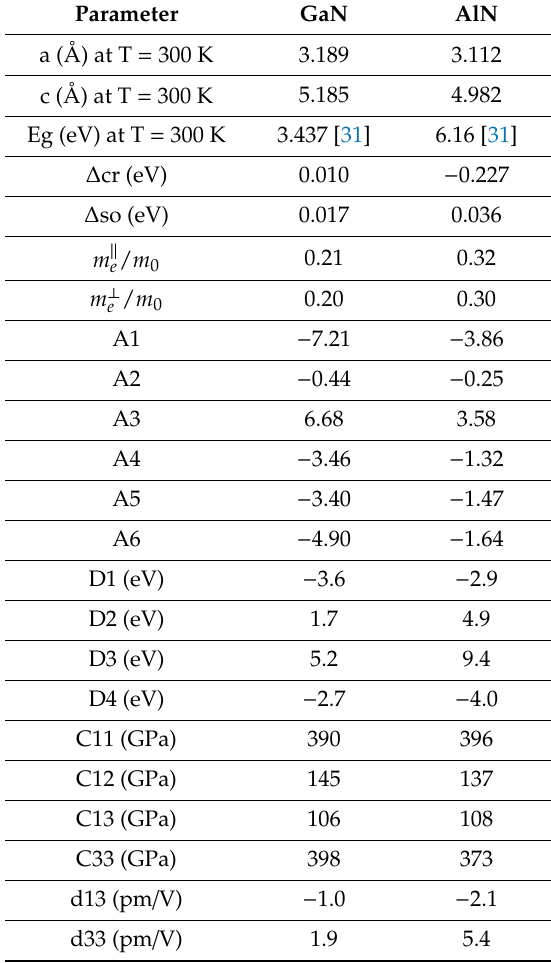
Figure 1. ( a ) Schematic of the AlGaN-delta-GaN structure studied in this work. The barrier thickness is fixed at 6 nm and the sub-QW thickness is 1.5 nm on each side of the delta-GaN layer. ( b ) Cross-sectional representation of the three-dimensional structure used for the finite difference time domain (FDTD) simulation. Perfectly matched layer (PML) and perfect electric conductor (PEC) boundary conditions (BC) are shown at the domain surfaces, MQW stands for multiple quantum well. Table 1. Material parameters for GaN and AlN